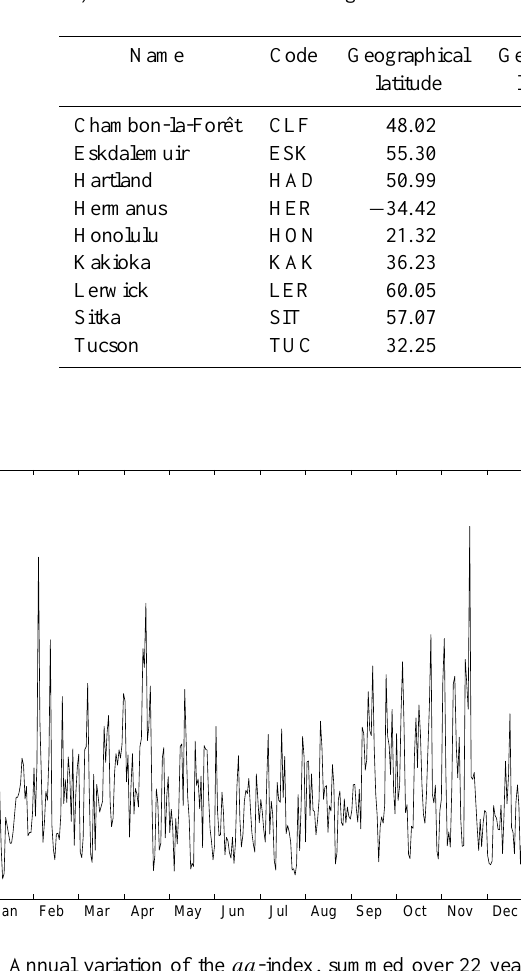
Fig. 1. Annual variation of the aa -index, summed over 22 years from 1868 to